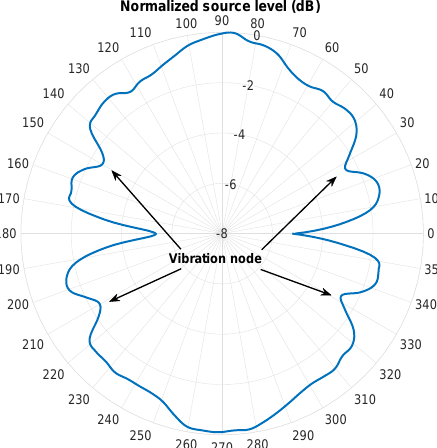
Figure 17. The measured circumferential pressure beam pattern of the transducer at its first mode of vibration (155 kHz). At zero degrees the measurement line is aligned and parallel with the surface of the stainless-steel layer and at 90 degrees it is aligned and perpendicular respect to the top of the transducer’s